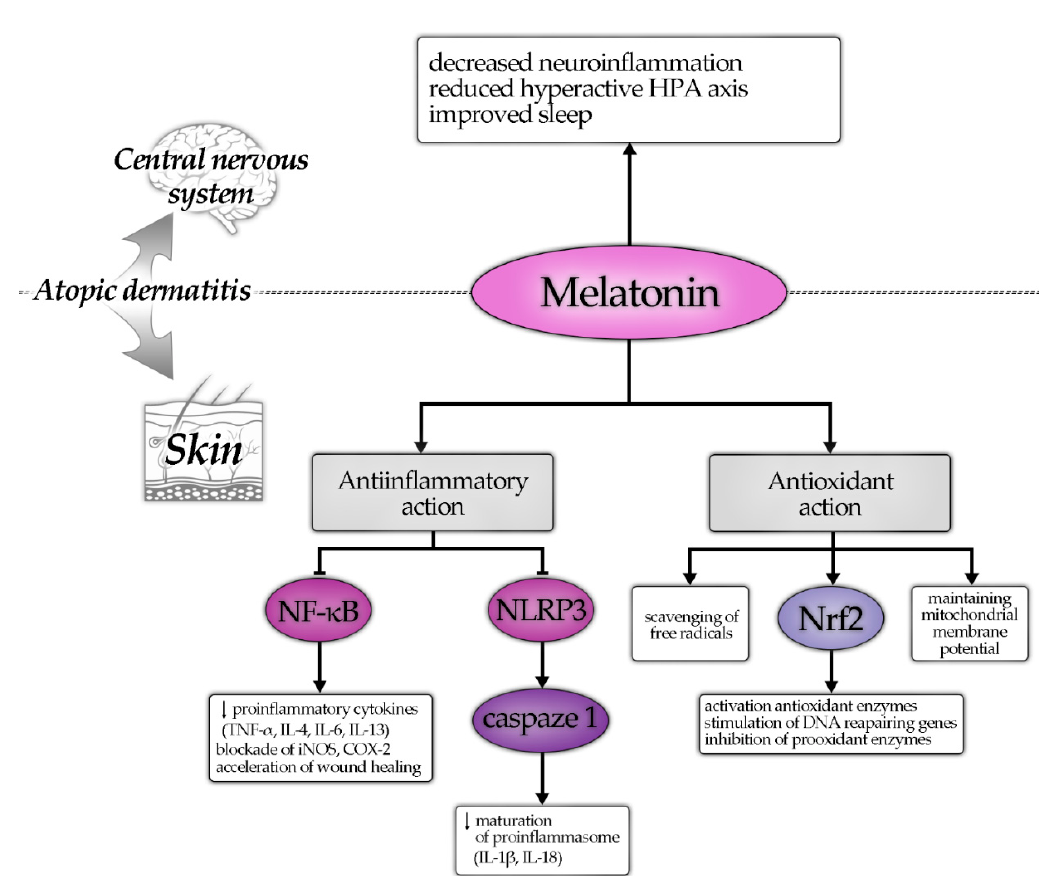
Figure 1. Protective effects of melatonin on atopic dermatitis—hypothetic mechanisms of action. Note: the arrow ( ↓ ) means, that the decrease in given entity is observed.